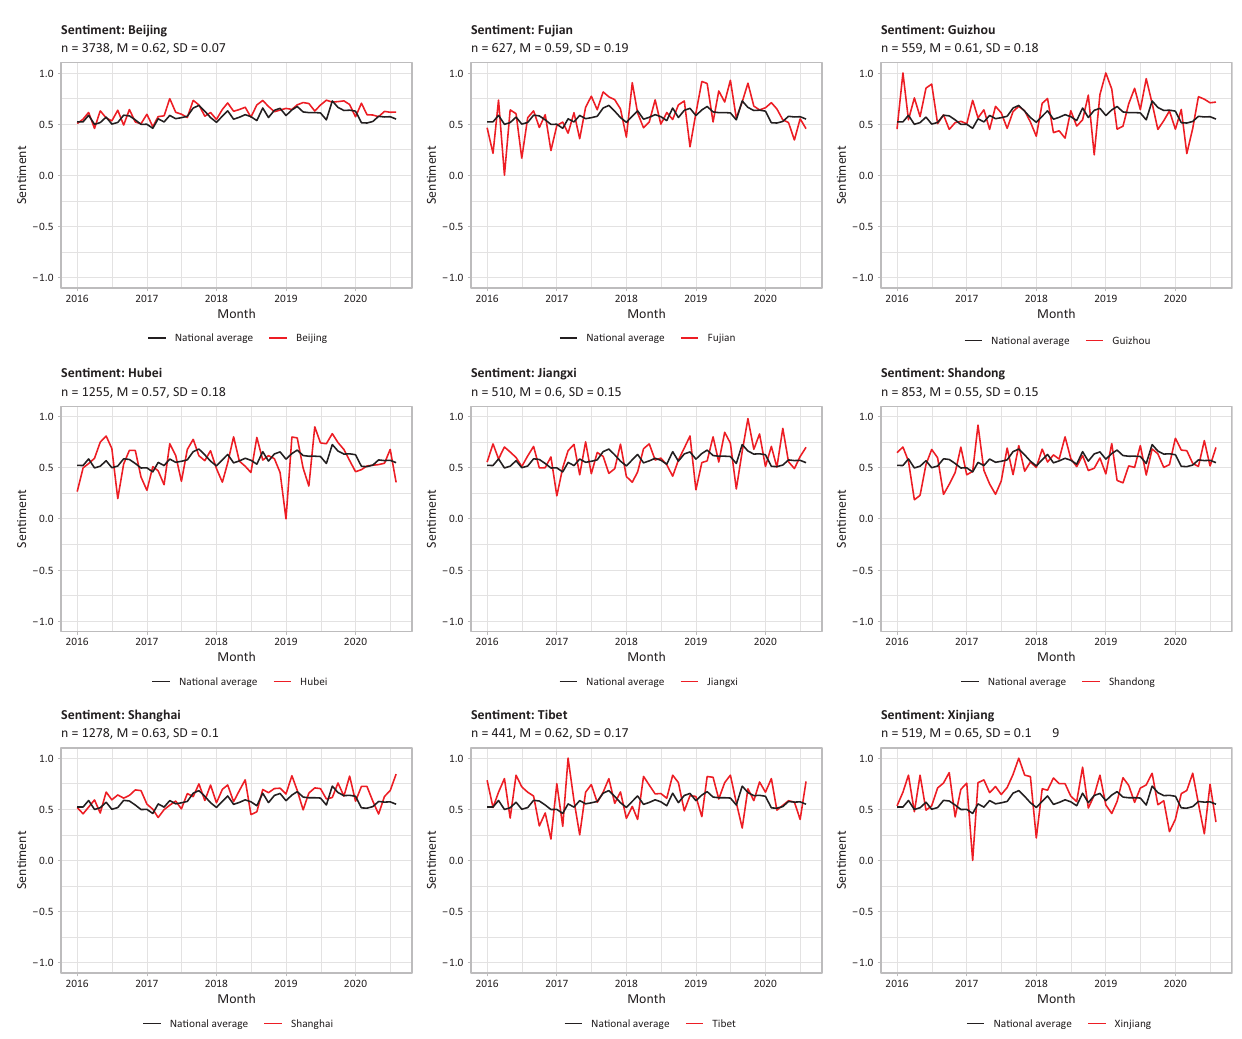
Figure 6. Monthly average sentiment for select provinces. Notes: Over the long term, no news coverage of provinces in China seriously deviated from the mean sentiment values. Some provinces with fewer mentions per month have noisier data and greater